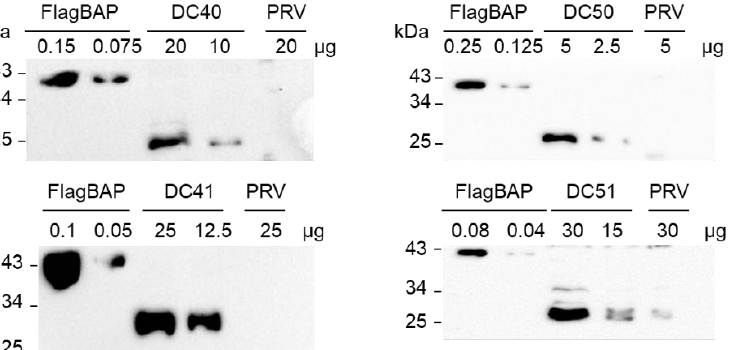
Figure 5. Detection of TaAA9B (DC40 and DC41 transplastomic plants) and TrAA9B (DC50 and DC51 transplastomic plants) recombinant proteins by Western blot analysis. Each transplastomic line shows a protein band corresponding in size to the recombinant protein. PRV, control plants transformed with an empty vector; FlagBAP, N-terminal FLAG fusion protein of E. coli bacterial alkaline phosphatase.